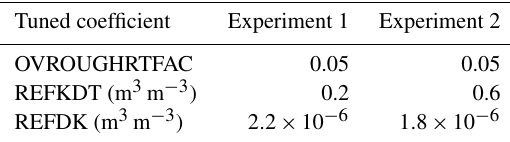
Table 4. Tuned coefficients of WRF-Hydro/NOAH-MP for both ex- periments. OVROUGHRTFAC is the overland roughness scaling factor, REFKDT is the infiltration coefficient and REFDK is the saturation of soil hydraulic